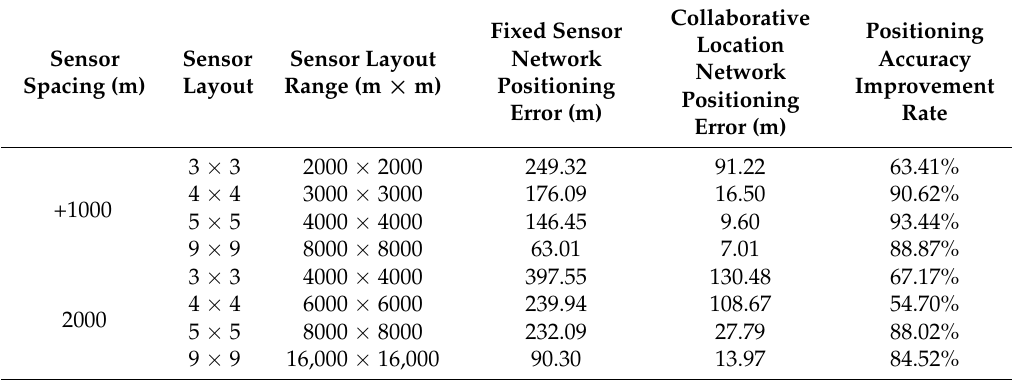
Table 4. Test positioning error results of different sensor